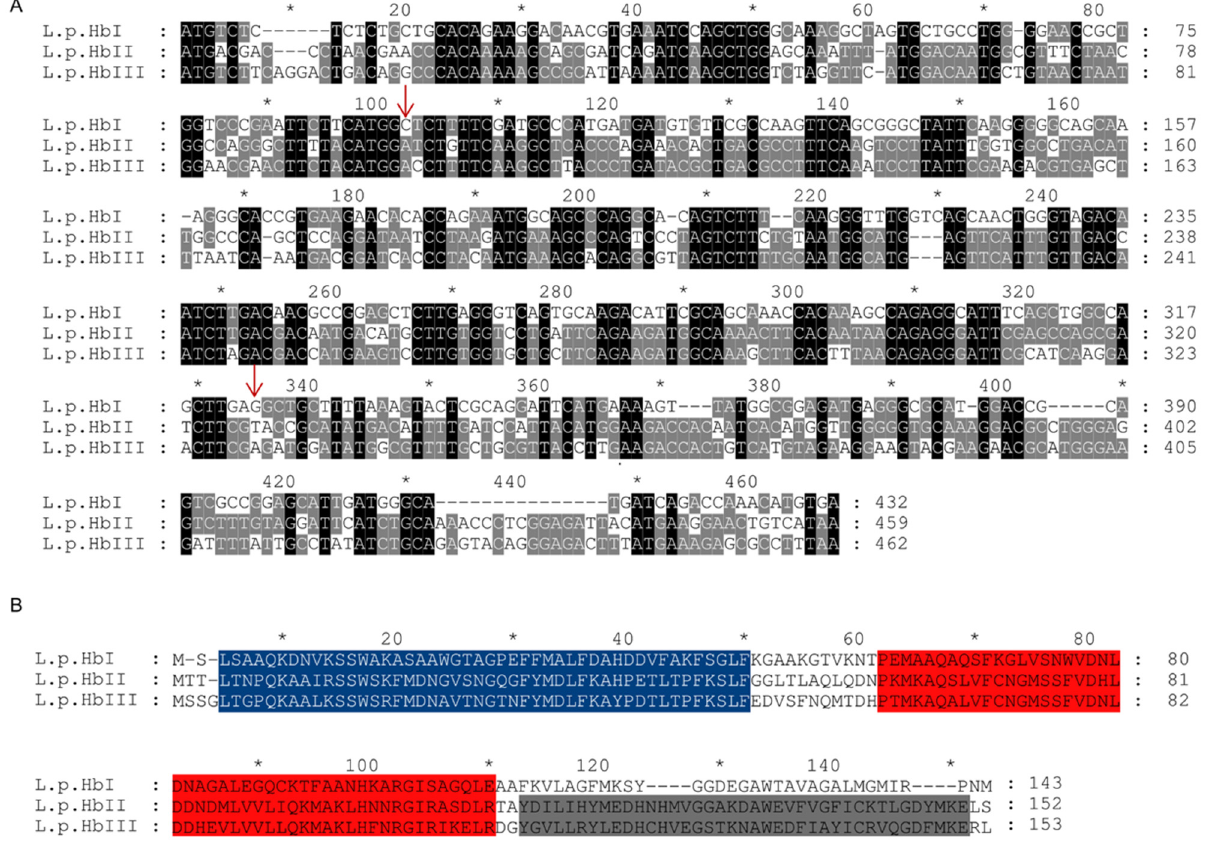
Figure 6. ( A ) Multiple sequence alignment and conservation levels of the coding regions of hemo- globins from L. pectinata . Conservation levels between the three coding region sequences of HbI Lp , HbII Lp and HbIII Lp of L. pectinata were visualized using GeneDoc. Nucleotides shaded in black rep- resent 100% of conservation, in gray, 66% conservation, and nucleotides having less than 66% con- servation were not shaded . Red arrows indicate position of intron insertions. ( B ) Multiple sequence alignment of L. pectinata hemoglobins . MSAs were carried out using M-COFFEE and visualized in GeneDoc. Motif analysis was performed using MEME and identified motifs are represented in dif- ferent colors.